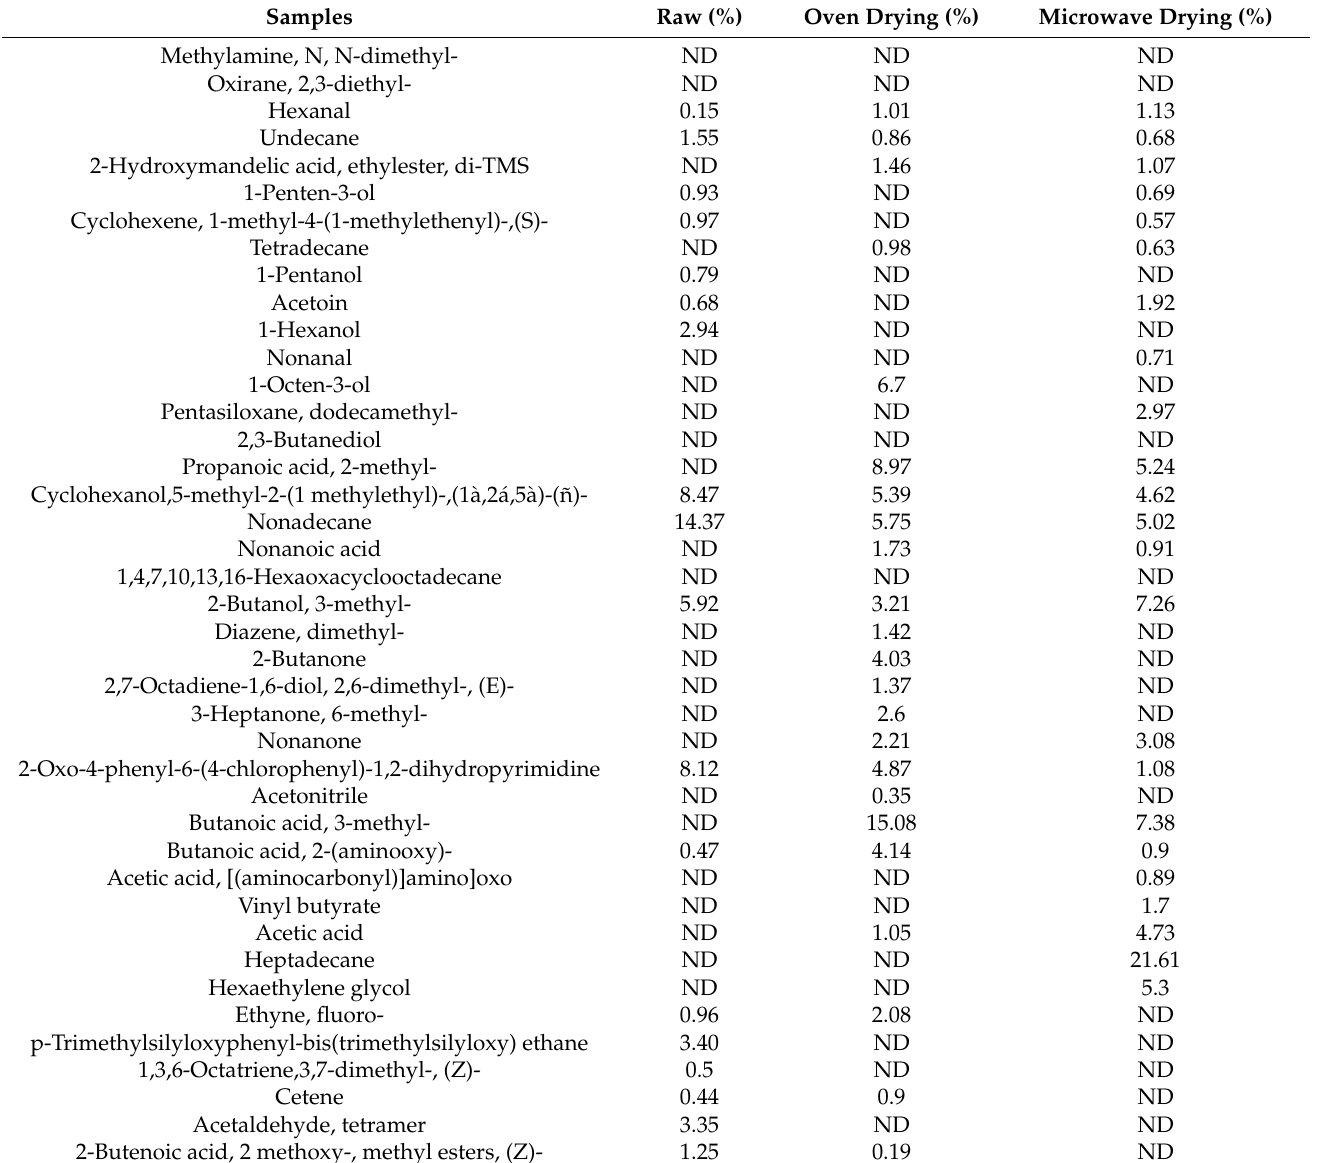
Table 3. Volatile compounds of raw, oven, and microwave drying of bighead carp H. nobilis fillets.